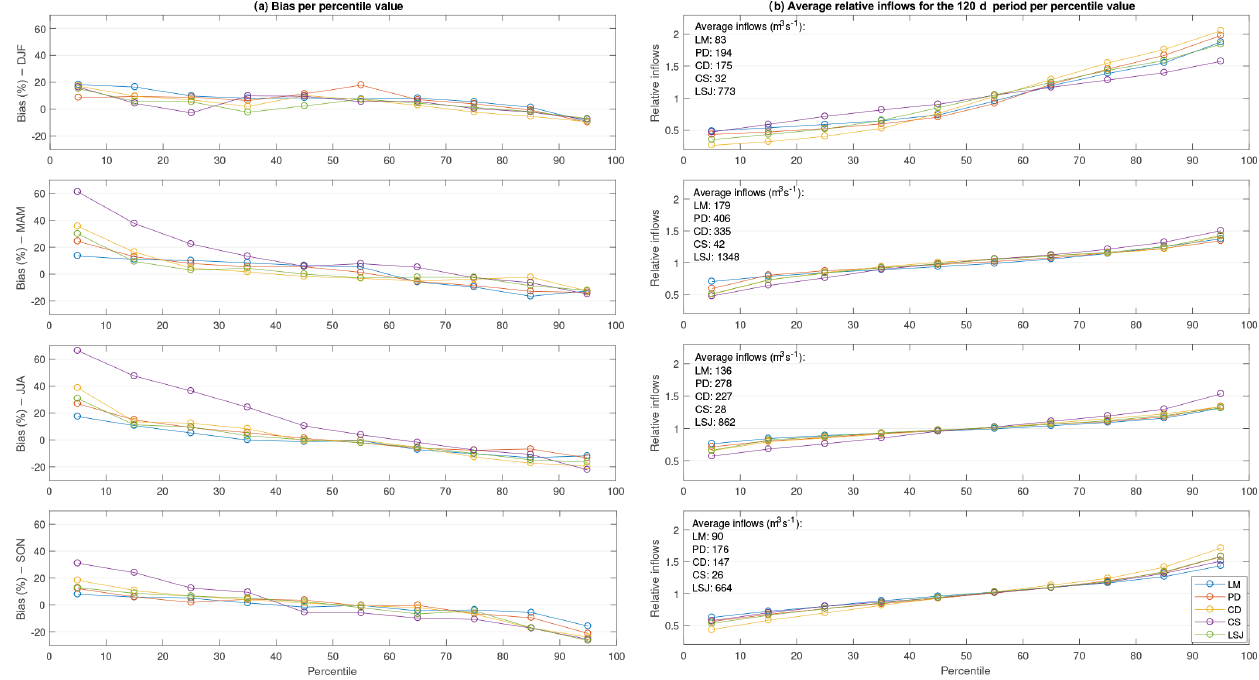
Figure 3. Bias for each catchment discriminated per season and per percentile of observed flow (a) and relative average inflows for the 120d period populating the figure, also discriminated by season (DJF is December, January, February, for example.) and percentile value (b) .